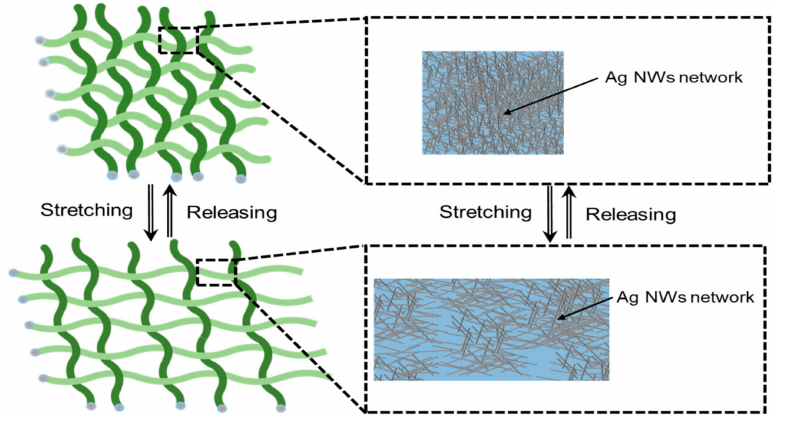
Figure 4. Schematic view of Silver nanowires (Ag NWs) layer before and after applying stretching